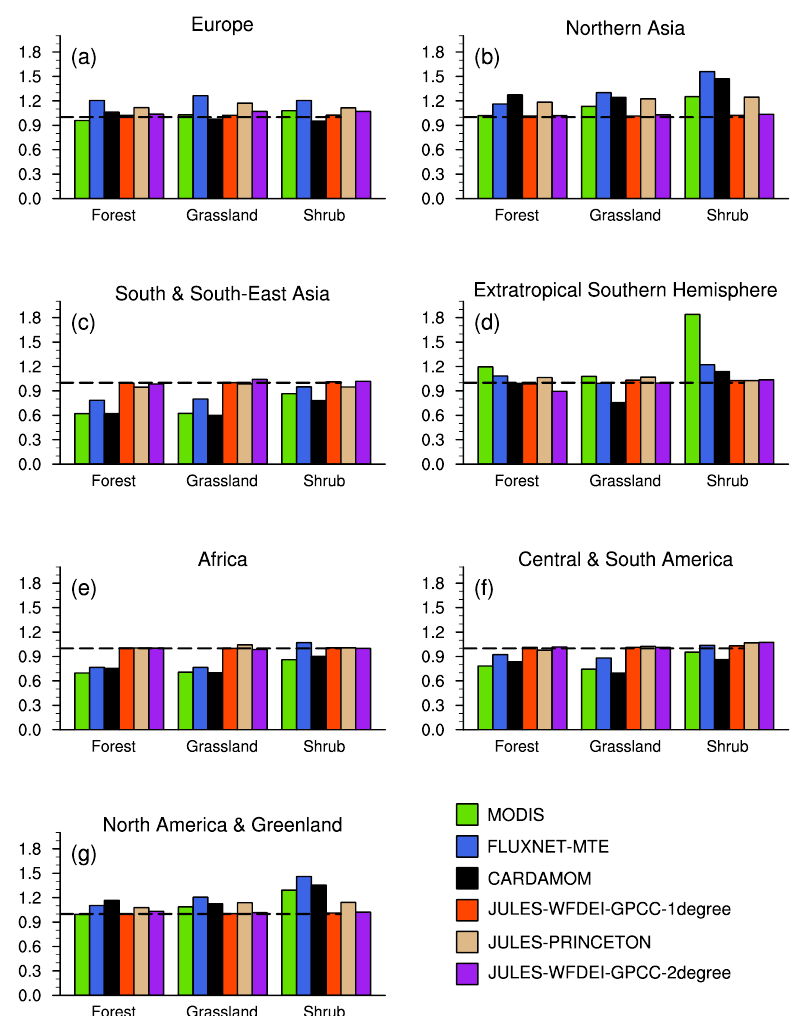
Figure 6. Total annual model-simulated (JULES-WFDEI-GPCC-1degree, JULES-PRINCETON, CARDAMOM and JULES-WFDEI- GPCC-2degree) and observed (FLUXNET-MTE and MODIS) GPP fluxes for the 2001–2010 period normalised by model-simulated (JULES- WFDEI-GPCC) GPP for various regions (Table 2) for three biome types (forest, grassland and shrub). Panels show normalised GPP (a) for Europe, (b) for northern Asia, (c) for South & South-Asia, (d) for extratropical Southern Hemisphere, (e) for Africa, (f) for Central & South America and (g) for North America & Greenland. The dotted line at y = 1 represents where the model and observations match.